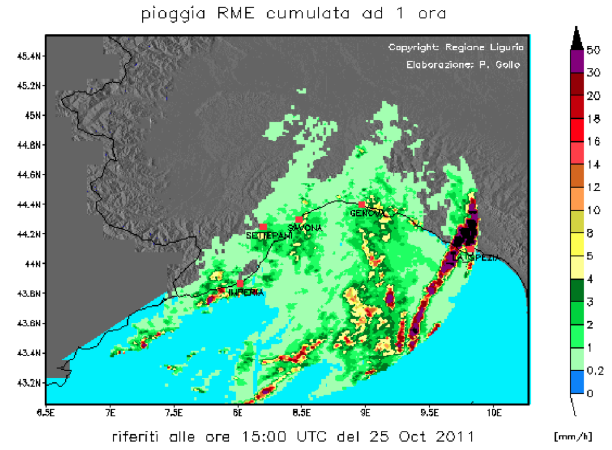
Figure 4. Radar reflectivity, 15:00UTC of 25 October 2011 (cour- tesy of Regione Liguria). Latitudes and longitudes are indicated on the left and bottom axes,